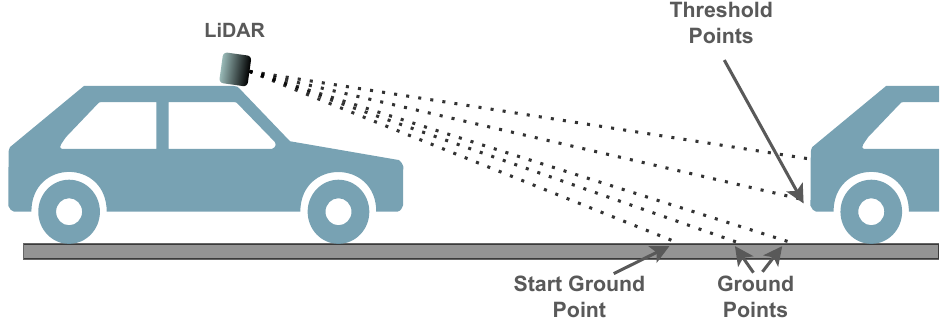
Figure 12. Representation of the channel-based